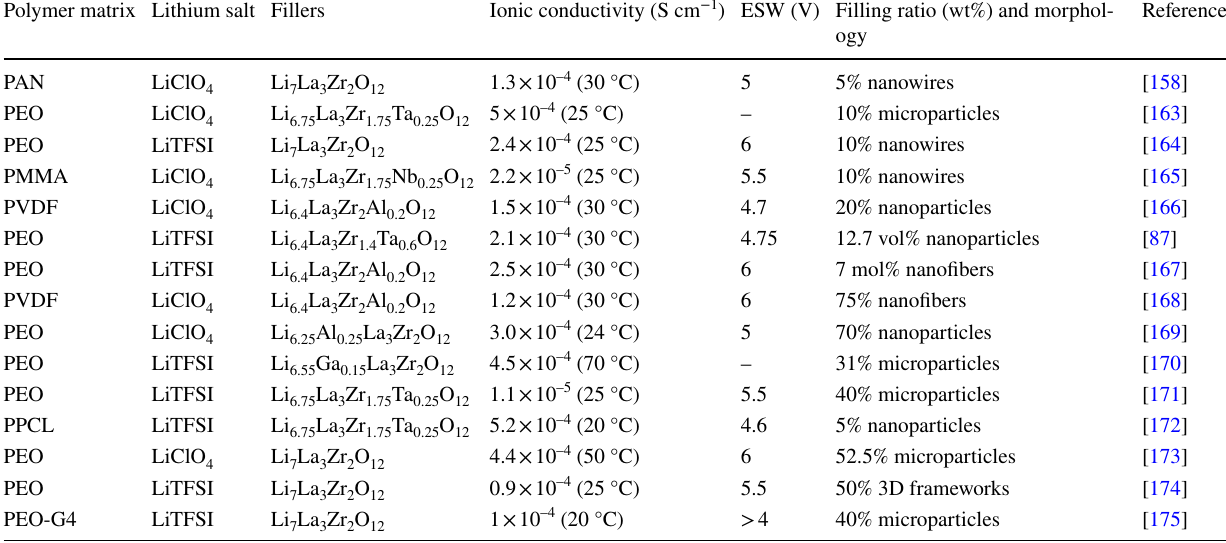
Table 3 PIEs filled with garnet-type fillers and their properties Polymer matrix Lithium salt